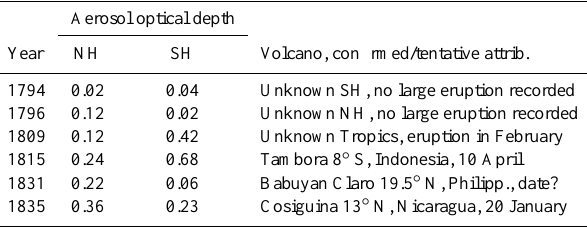
Table 1. Stratospheric aerosol optical depths at 550nm derived from volcanic aerosol simulations (Arfeuille et al., 2014) using ice core measurements from Gao et al. (2008).